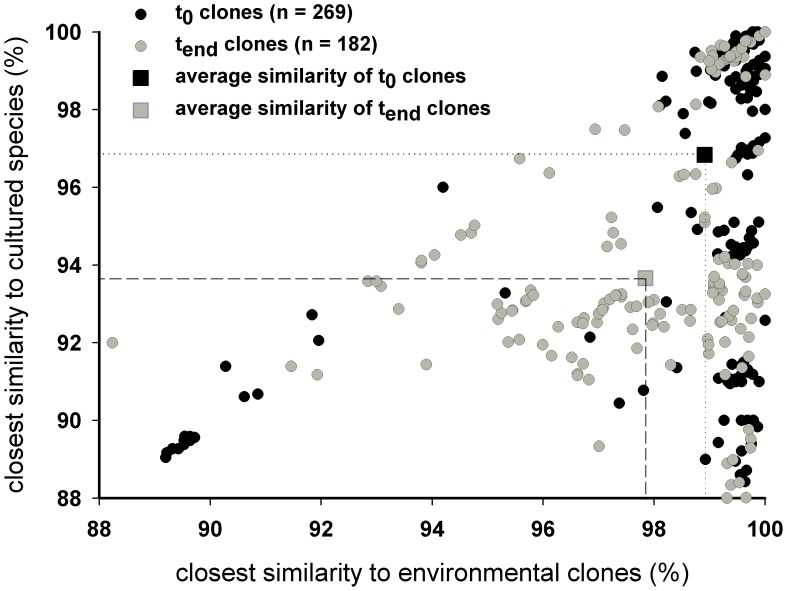
Novelty pattern determined for all clones obtained at the start and end of incubation experiments.Each circle represents one clone and its percent similarity to the closest environmental clone and the closest cultured species in GenBank. The mean similarity to both is indicated by the squares.